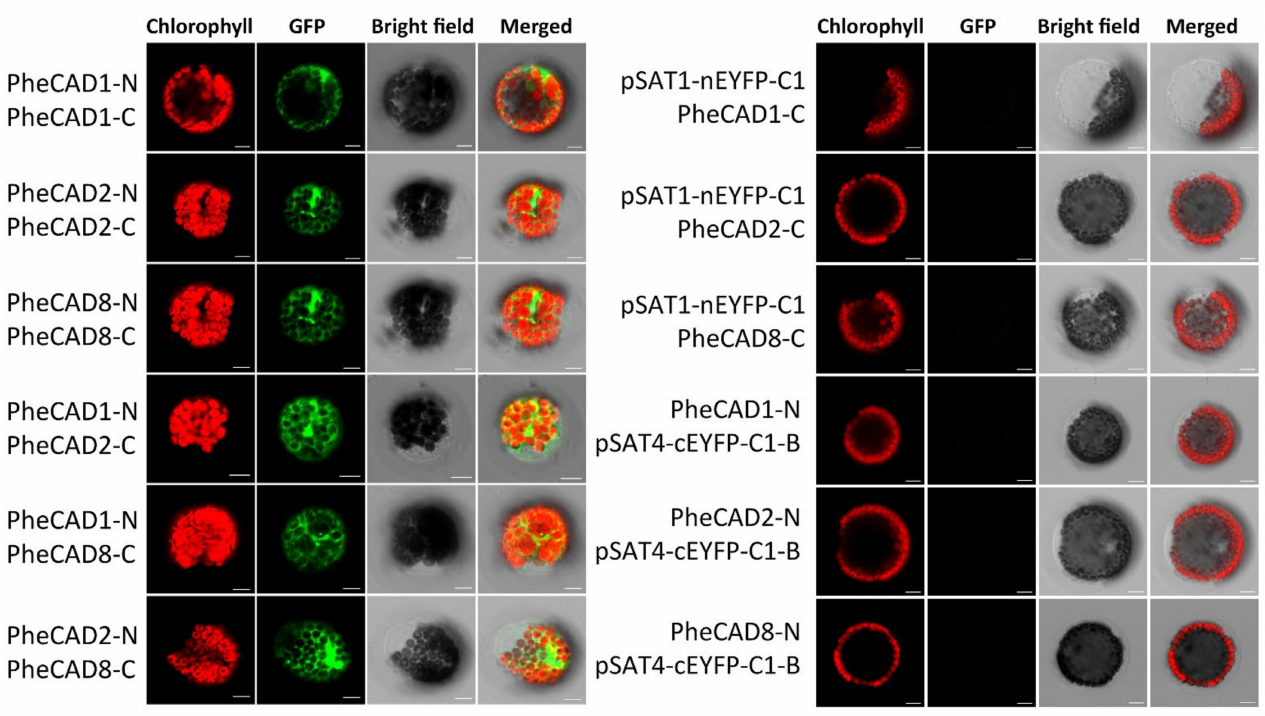
Figure 7. Pairwise bimolecular fluorescence complementation assay of PheCAD1 , PheCAD2 and PheCAD8 enzymes in Arabidopsis protoplast cells. Empty vector and corresponding C-terminal or N-terminal PheCAD genes were used as the negative control. Scale bar, 10 µ